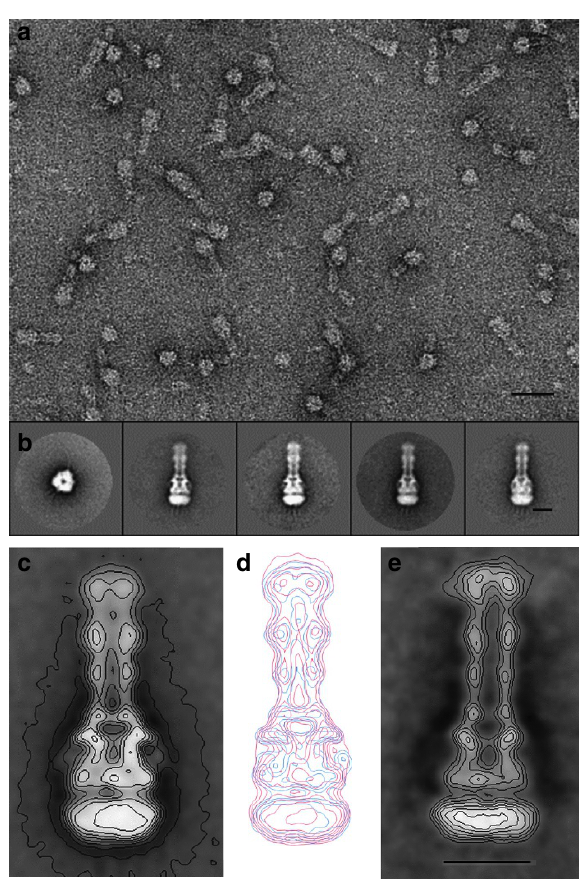
Figure 5 | TEM analysis of tripartite AcrAB–TolC and AcrA–MexB–TolC assemblies. ( a ) Field of view revealing purified AcrAB–TolC assemblies. Scale bar, 30nm. ( b ) Gallery of one top view class average (137 images) and four class average side views of a 33-nm-long tripartite AcrAB–TolC complex (223, 119, 196, 178 images, respectively) and. ( c ) Enlarged average image of tripartite AcrAB–TolC assembly. ( d ) Isocontours of tripartite AcrAB–TolC assembly (red) overlaid on isocontours of tripartite MexAB– OprM assembly (blue). ( e ) An average of tripartite AcrA–MexB–TolC assembly. Scale bar, 10nm for c , d , e